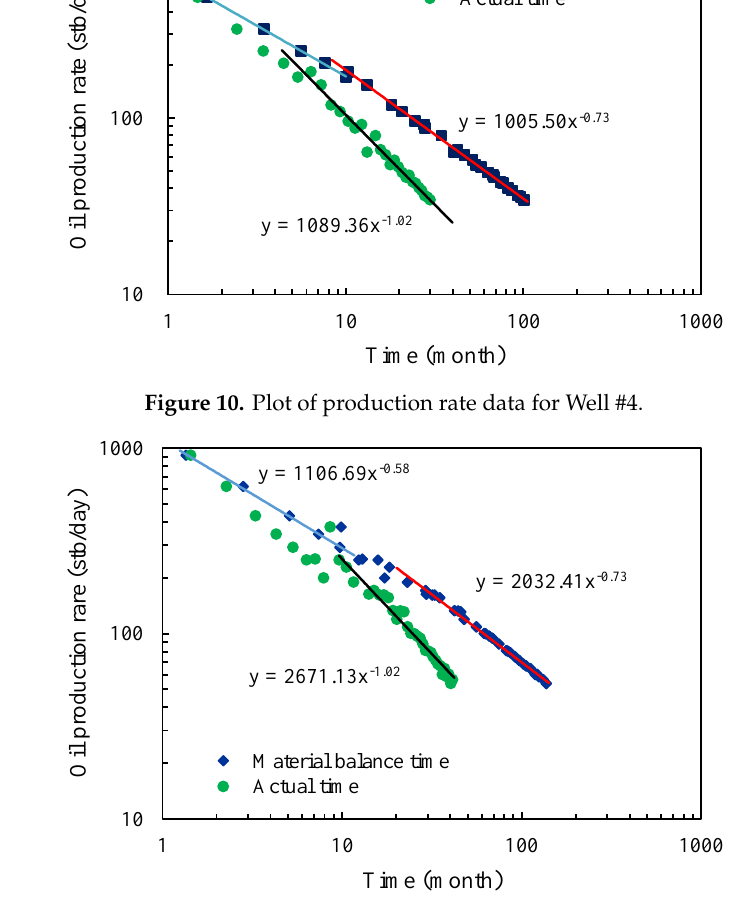
Figure 11. Plot of production rate data for Well